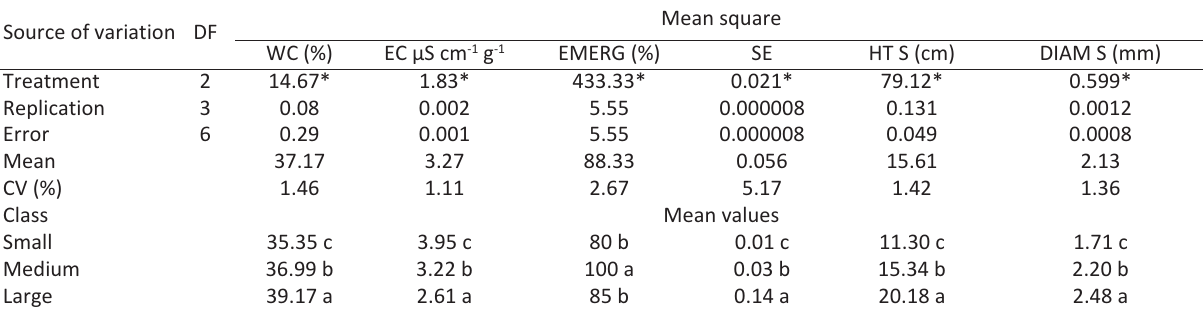
Table 3 - Summary of the analysis of variance and comparison of mean values for water content (WC, %), electrical conductivity (EC, μS cm -1 g -1 ), emergence (EMERG, %), speed of emergence, (SE, index), seedling height (HT S, cm) and stem diameter (DIAM S, mm) in camu-camu seeds classified